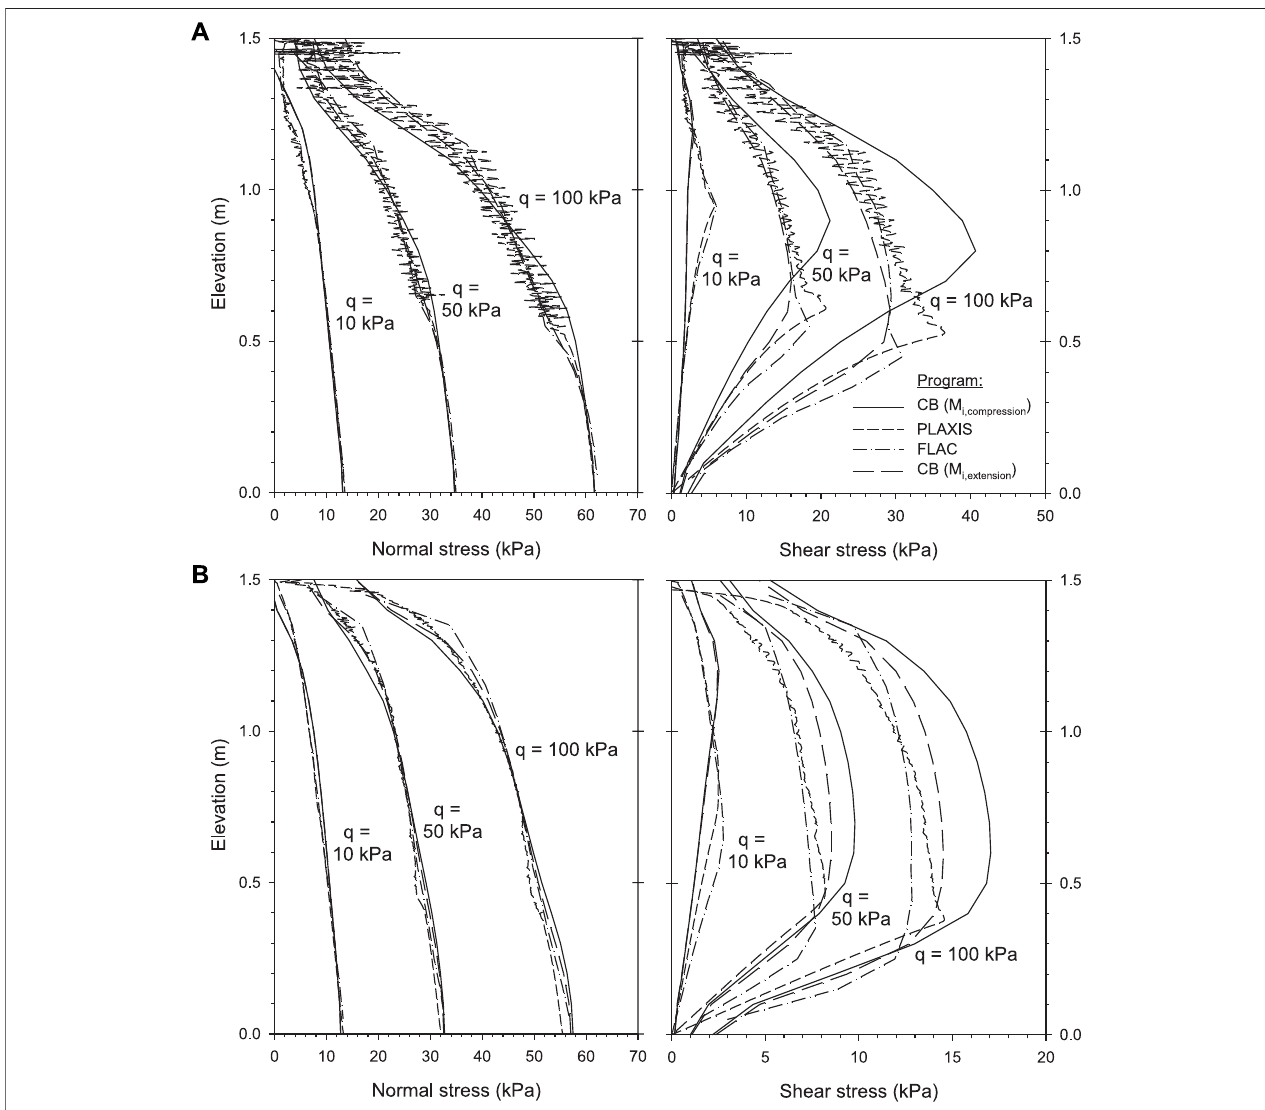
FIGURE 11 | Load transfer from back fi ll soil to facing panel: comparison of normal and shear stresses using PLAXIS program (continuum elements interface; optimized mesh), FLAC (continuum elements interface; coarse mesh), and CODE_BRIGHT (both Mi-compression and Mi-extension scenarios performed). Cases with (A) Ri = 0.8 and (B) and Ri =